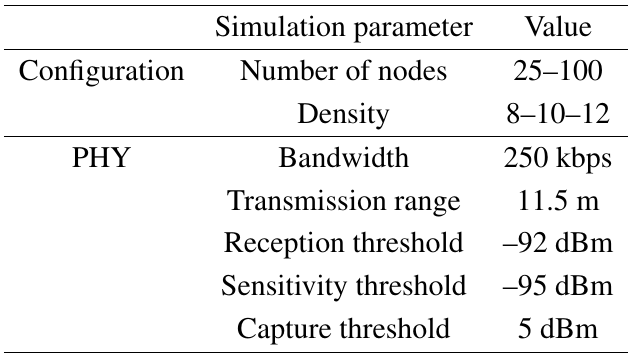
Table 6. Simulation